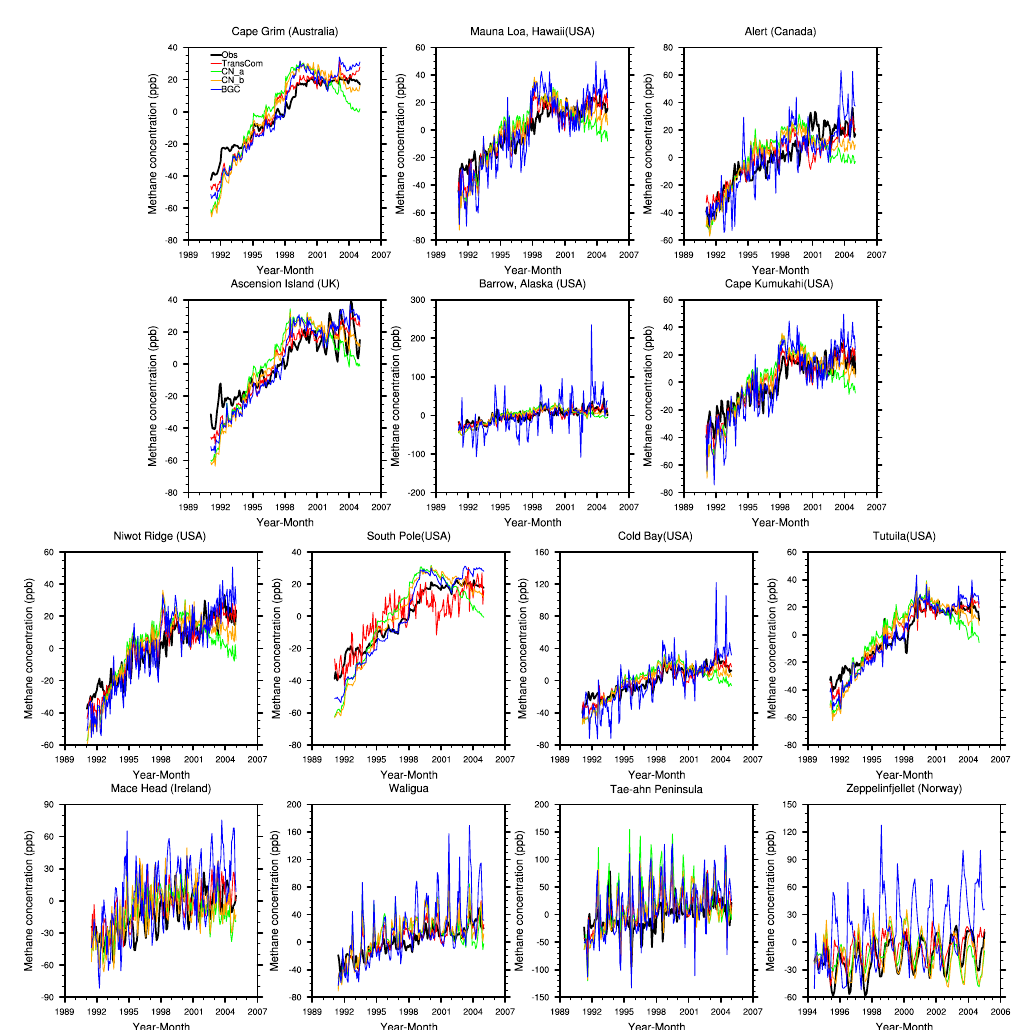
Figure 11. The comparison of model-simulated atmospheric CH 4 concentration at the closest grid box vs. observations. The climatological monthly mean is removed to focus on interannual variability in atmospheric CH 4 concentration at these stations. Model simulations are obtained from TransCom, CN_a, CN_b, and BGC experiments. The observational CH 4 concentration data set at these stations is from the World Data Centre for Greenhouse Gases (WDCGG) at